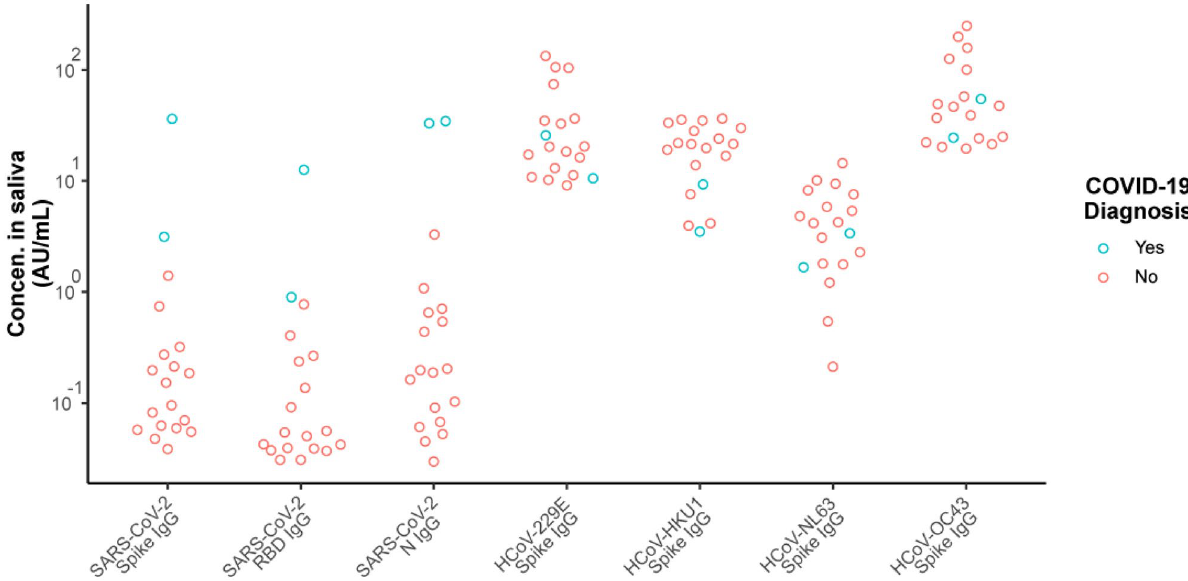
Figure 6. Salivary IgG antibodies measured in self-collected saliva returned via mail. Saliva collection kits were sent via the mail to individuals who requested a kit in response to an online recruitment posting. Donors provided self-collected saliva according to written instructions and completed a survey about COVID-19 testing, which were returned to MSD via a prepaid mailer. Nineteen samples were received, and tested for IgG antibodies to SARS-CoV-2 and circulating coronaviruses. Two donors (shown in blue), who reported a positive COVID-19 PCR test at least 30 days prior to providing a sample, had IgG anti-SARS-CoV-2 antibodies. All donors had levels of antibodies to circulating coronaviruses within the range of levels measured in samples within the local